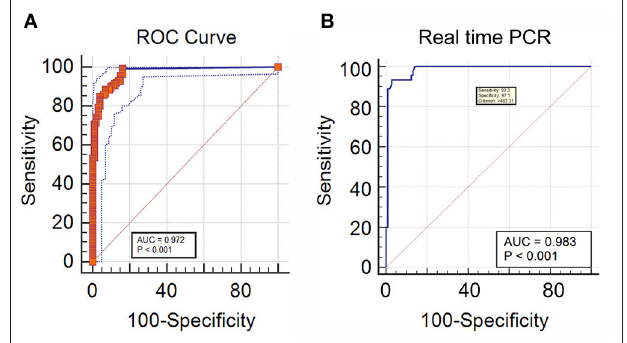
FIGURE 4 | (A) Receiver operator curve plotted significant DNA copy number cut-off for IA cases, classified according to two consecutive GM positivity